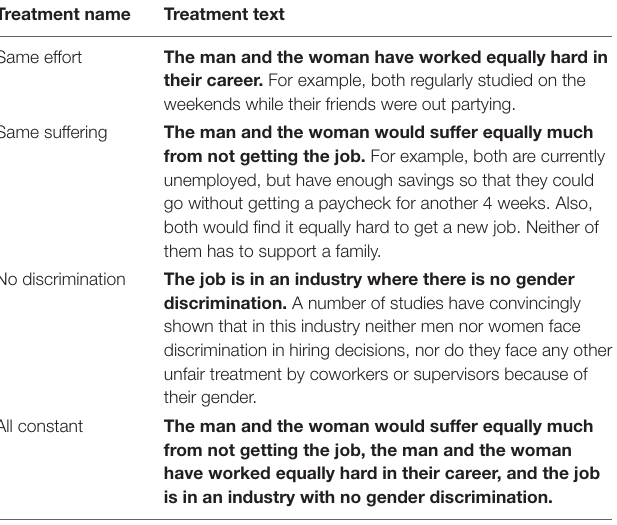
TABLE 3 | Treatment text for survey